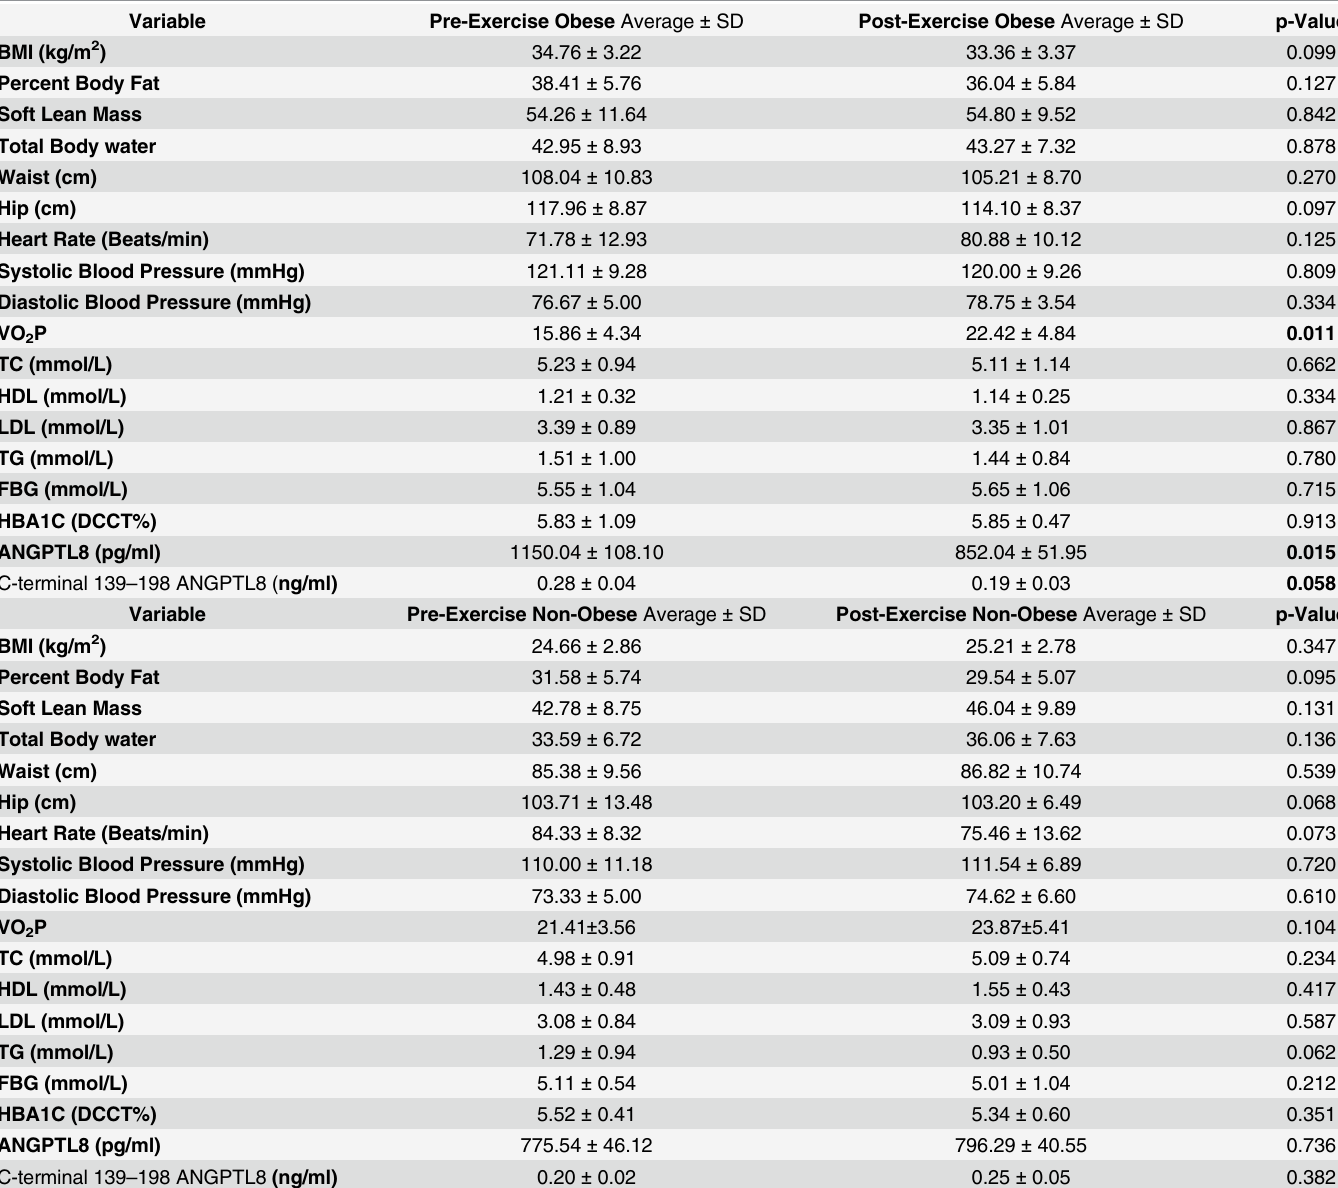
Table 2. Characteristics of the obese subjects before and after undertaking exercise